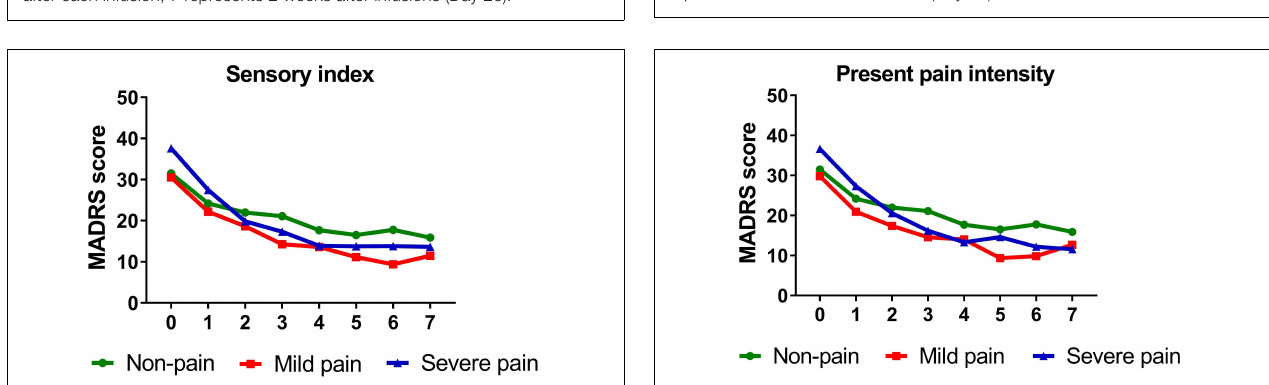
FIGURE 2 | Overall change in MADRS score across six infusions. Pain severity was defined by VAS. Patients exhibiting no pain symptom were characterized as “non-pain,” patients exhibiting the mean or below the mean VAS score were characterized as “mild pain” and patients exhibiting above the mean VAS score were characterized as “severe pain.” MADRS, Montgomery-Åsberg Depression Rating Scale; VAS, visual analog scale. Numbers on X -axis: 0 represents baseline, 1 ∼ 6 represent the next morning after each infusion, 7 represents 2 weeks after infusions (Day 26).